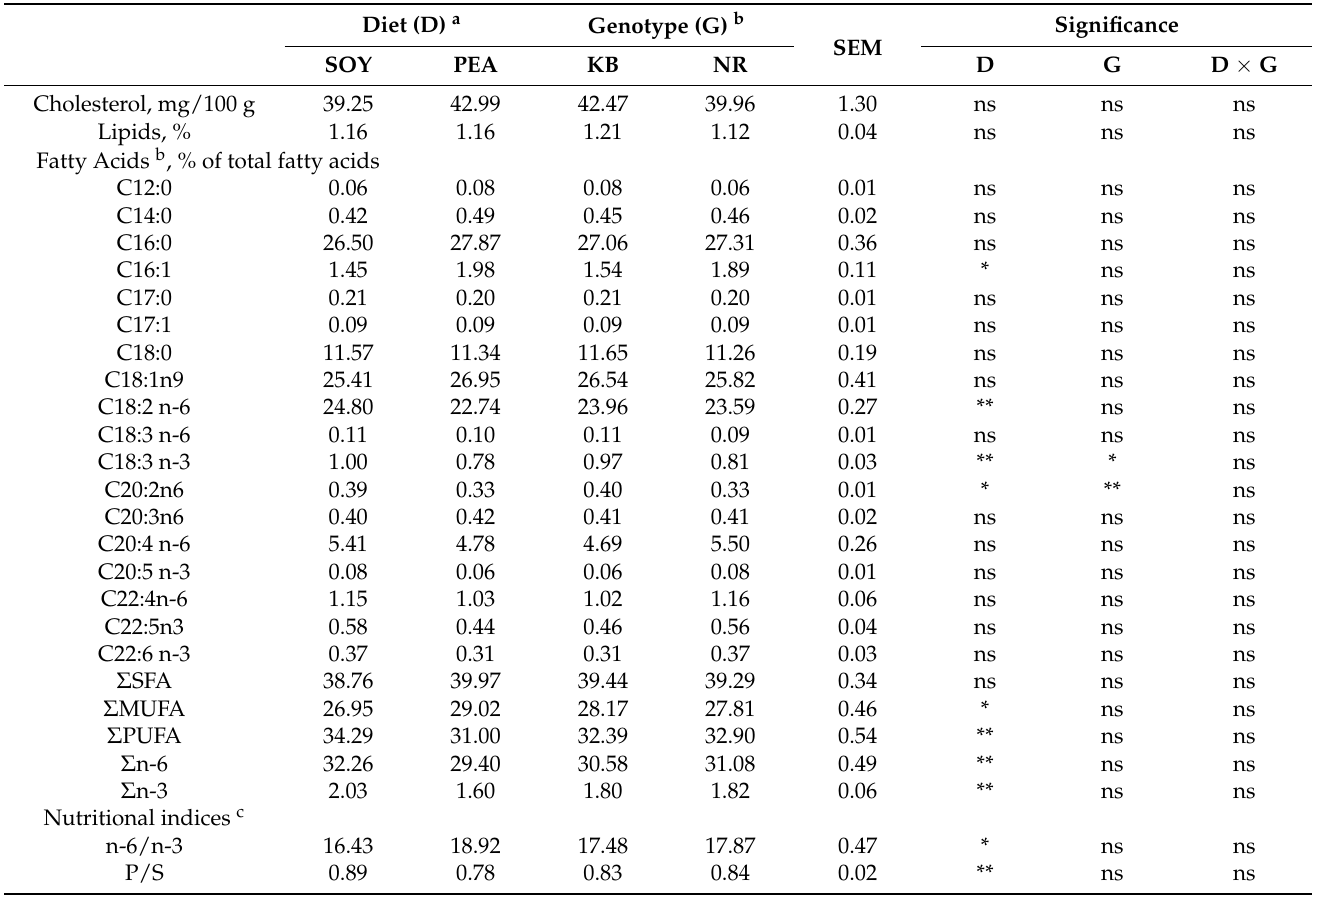
Table 4. Effect of genotype and diet on cholesterol and total lipid content, fatty acid composition and nutritional indices in the breast muscle of broiler chickens. Genotype (G)